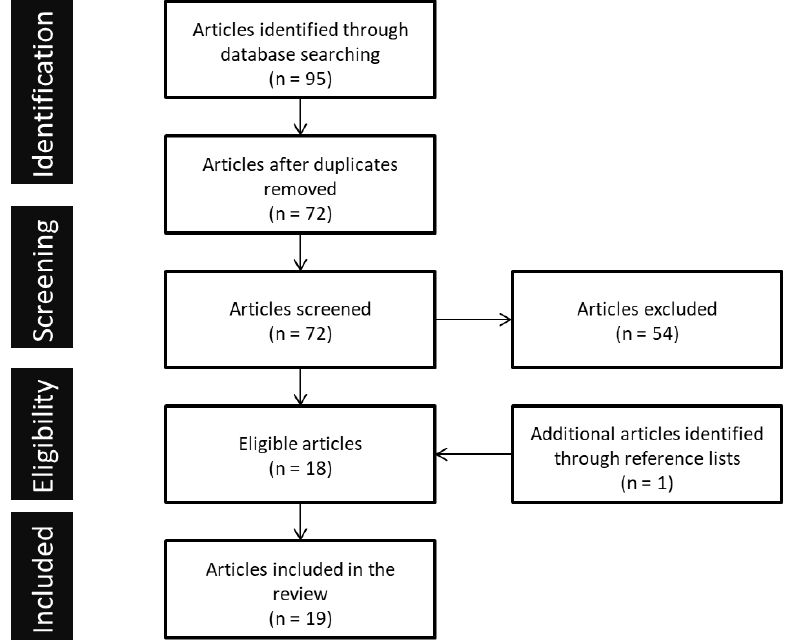
Figure 1. Summary of systematic review